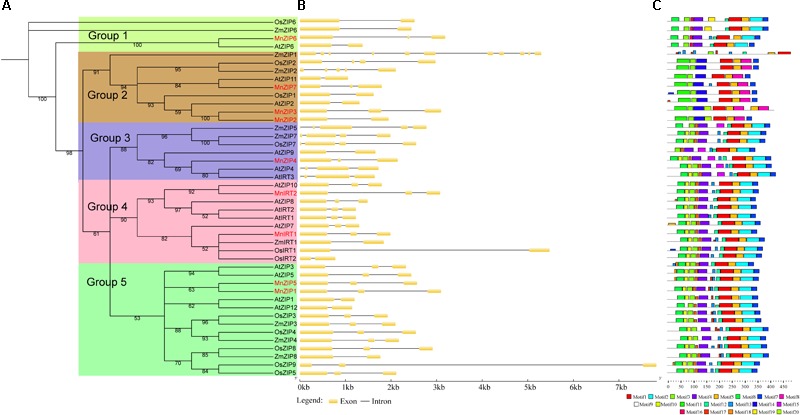
Phylogenetic relationships, gene structure and motif composition of ZIP genes in Arabidopsis (At), rice (Os), Morus (Mn) and other species. (A) Multiple sequence alignments of the full-length protein sequences of ZIP genes were performed using ClustalX version 2.1. Phylogenetic trees were constructed with the maximum likelihood method using TREE-PUZZLE 5.3. rc16. The number of puzzling steps was set at 10,000 times. Every colored box represents a subfamily. (B) Exon/intron structures. Yellow boxes and black lines represent exons and introns, respectively. (C) Schematic representation of the conserved motifs elucidated by MEME 4.11.2. A number in the colored box represents each motif, and the black lines represent the non-conserved sequences.